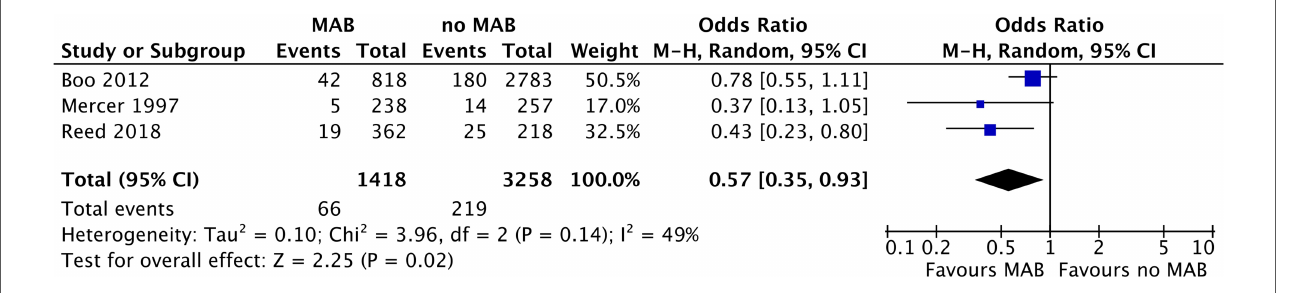
FIGURE 2 Forest plot of all included studies comparing MAB and no MAB. Events=the incidence of NEC development. Odds ratios were calculated using RevMan. MAB, maternal antibiotics; NEC, necrotizing enterocolitis; CI, con fi dence